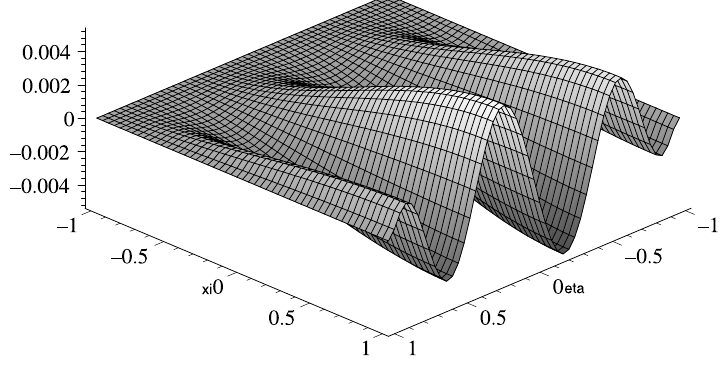
Fig. 3. Example of shape function defined by a product of a Hermite cubic by a higher order